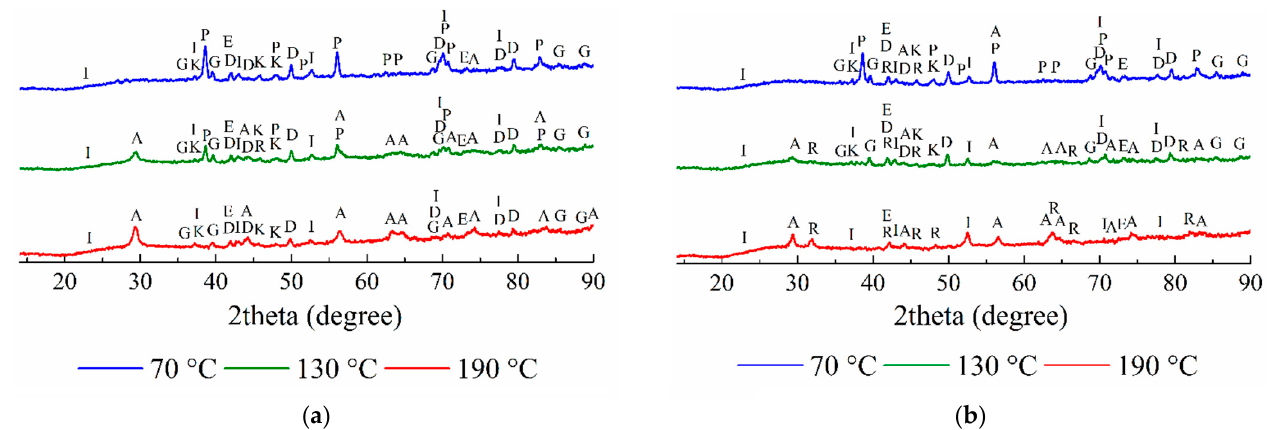
Figure 7. The XRD patterns of the solid residues after leaching of WAT sample using 10% ( a ) and 20% HCl ( b ), where P— CaTiO 3 ; A—TiO 2 (anatase); R—TiO 2 (rutile); G—Ca 3 Al 2 Si 3 O 12 ; K—Ca 3 Al 2 Si 3 (OH) 12 ; E—Mg 3 Al 2 Si 3 O 12 ; D—5Al 2 O 3 ∙ H 2 O; I—MgAl 2 O 4 .